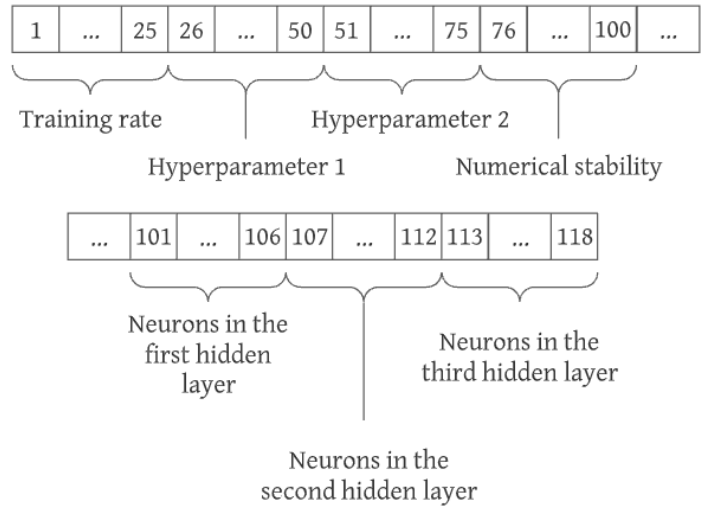
Figure 3. Illustration of the individual representation used in genetic algorithm